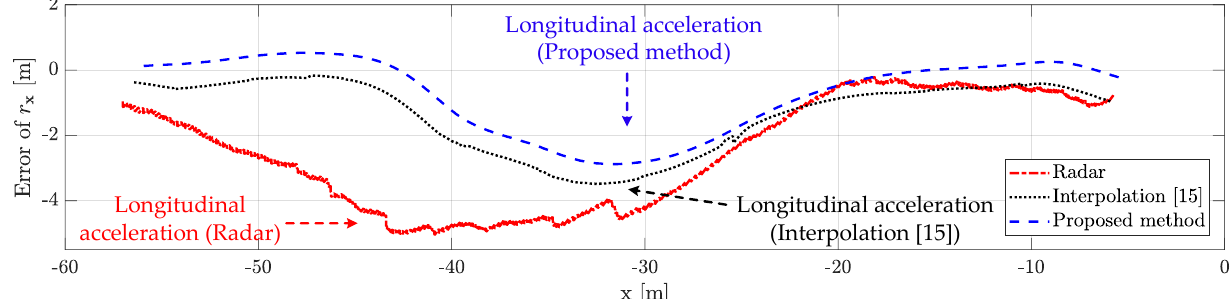
Figure 11. Longitudinal distance error for scenario-based object estimation: the proposed method outperforms the conventional radar estimation method and the previous interpolation method. However, there is a longitudinal error in all methods due to latency for longitudinal acceleration in the acceleration area.